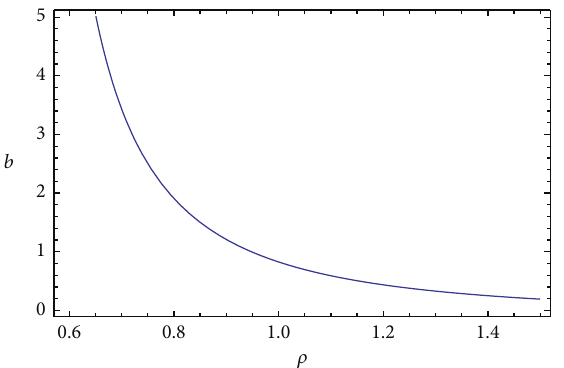
Figure 7: Magnetic field 𝑏 as a function of 𝜌 . One can notice that magnetic field decreases abruptly away from the black hole.